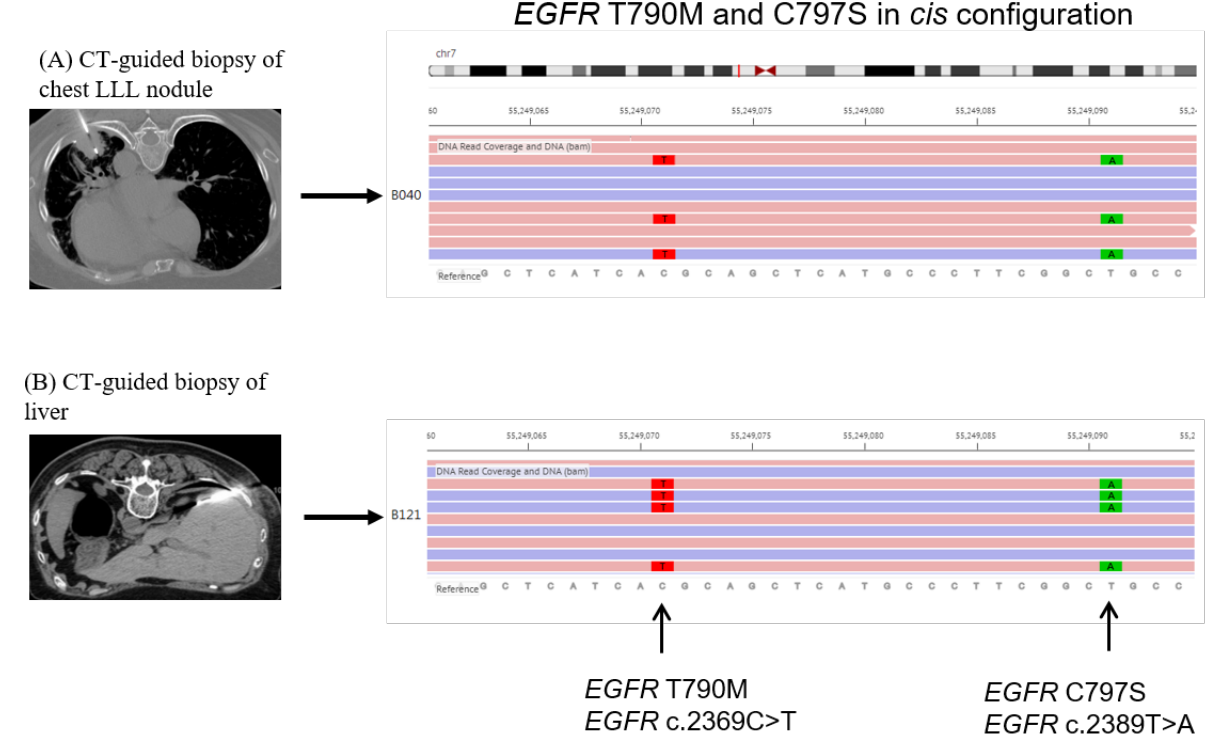
Figure 3. Next generation sequencing (provided by GenPan52-TBx, Genconn Biotech, Taiwan) from biopsies of LLL nodule ( A ) and liver ( B ) both showed EGFR T790M and C797S in cis-configuration.